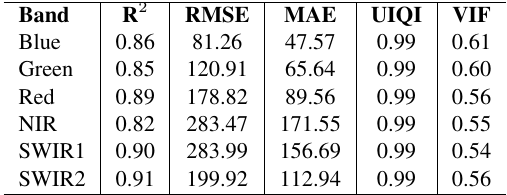
Table 3: Validation agreement of our pixel weighting multiscale segmentation gap-filling method on bands Blue, Green, Red, NIR, SWIR 1 and SWIR 2, obtained by simulating SLC-off effect using Landsat-8/OLI